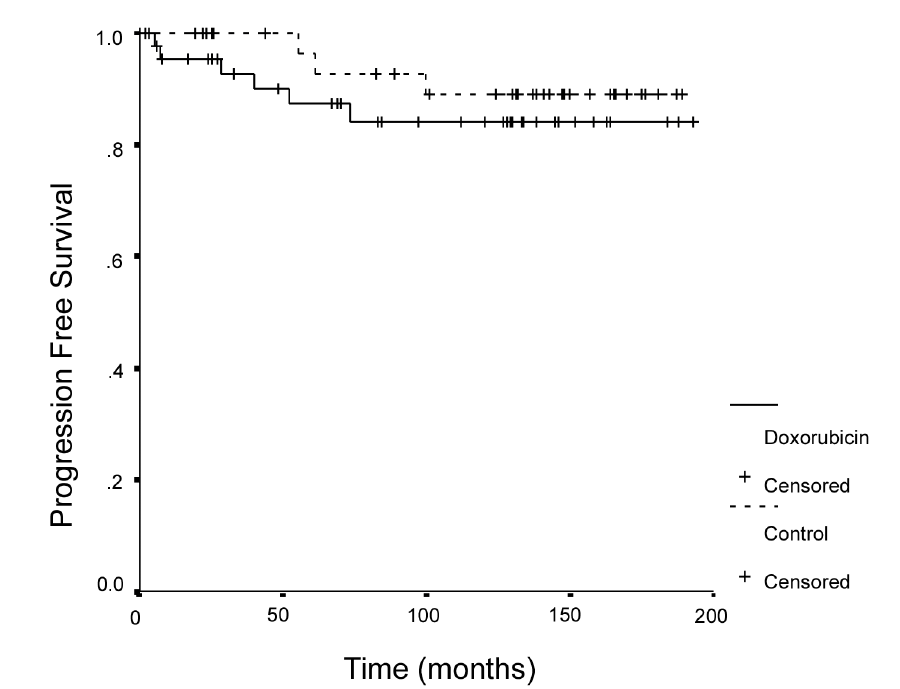
Figure 2 – Progression free survival curves of doxorubicin group (solid line) and control group (dotted line). Log rank test, p =